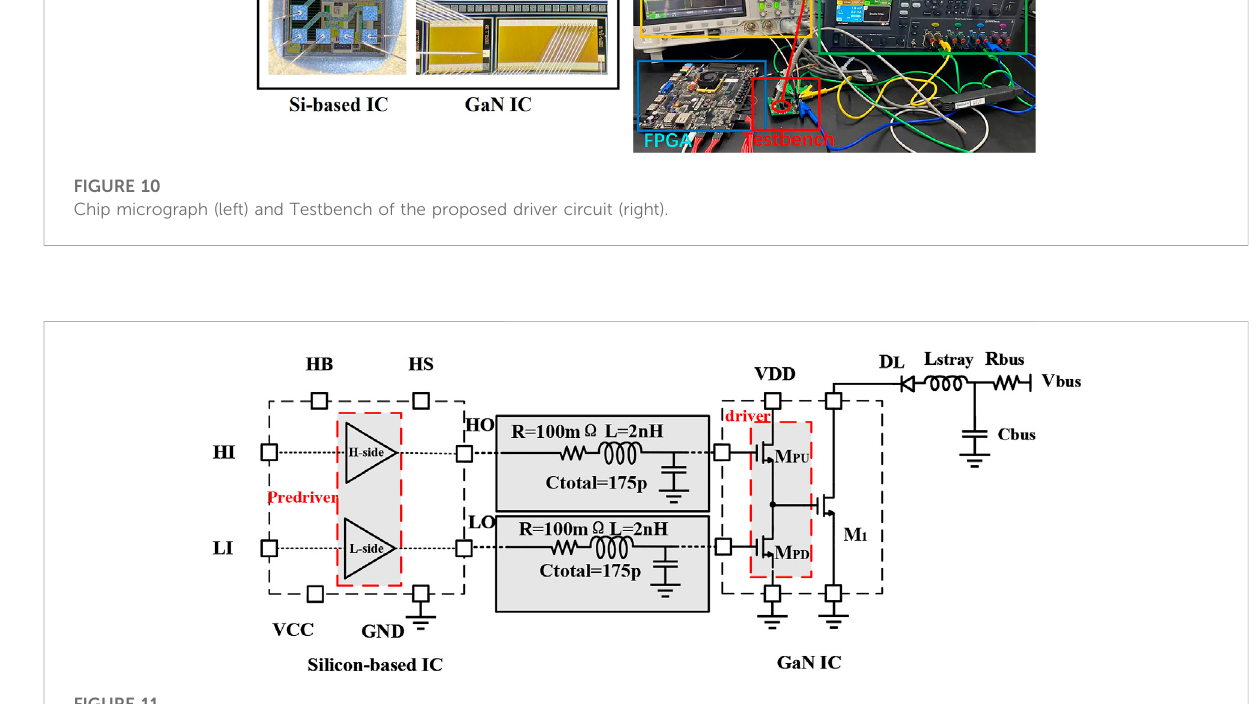
Diagram of the simulation model equivalent